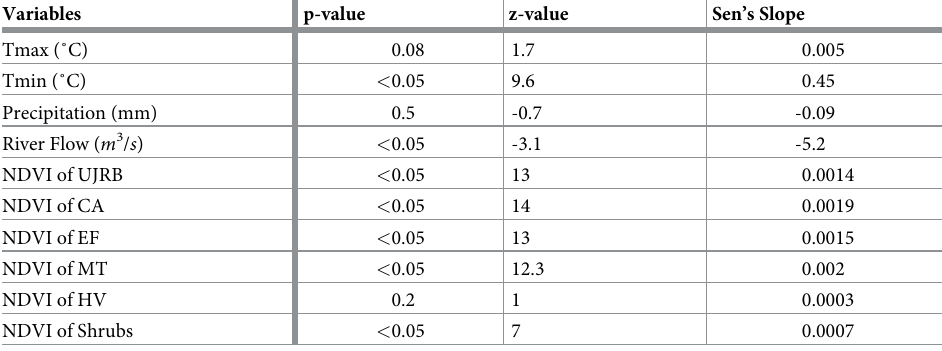
Table 1. Annual Mann-Kendall trend statistics calculated from spatially averaged data of NDVI, precipitation, maximum temperature (Tmax) and minimum temperature (Tmin) for each vegetation type during 1982 to 2015.